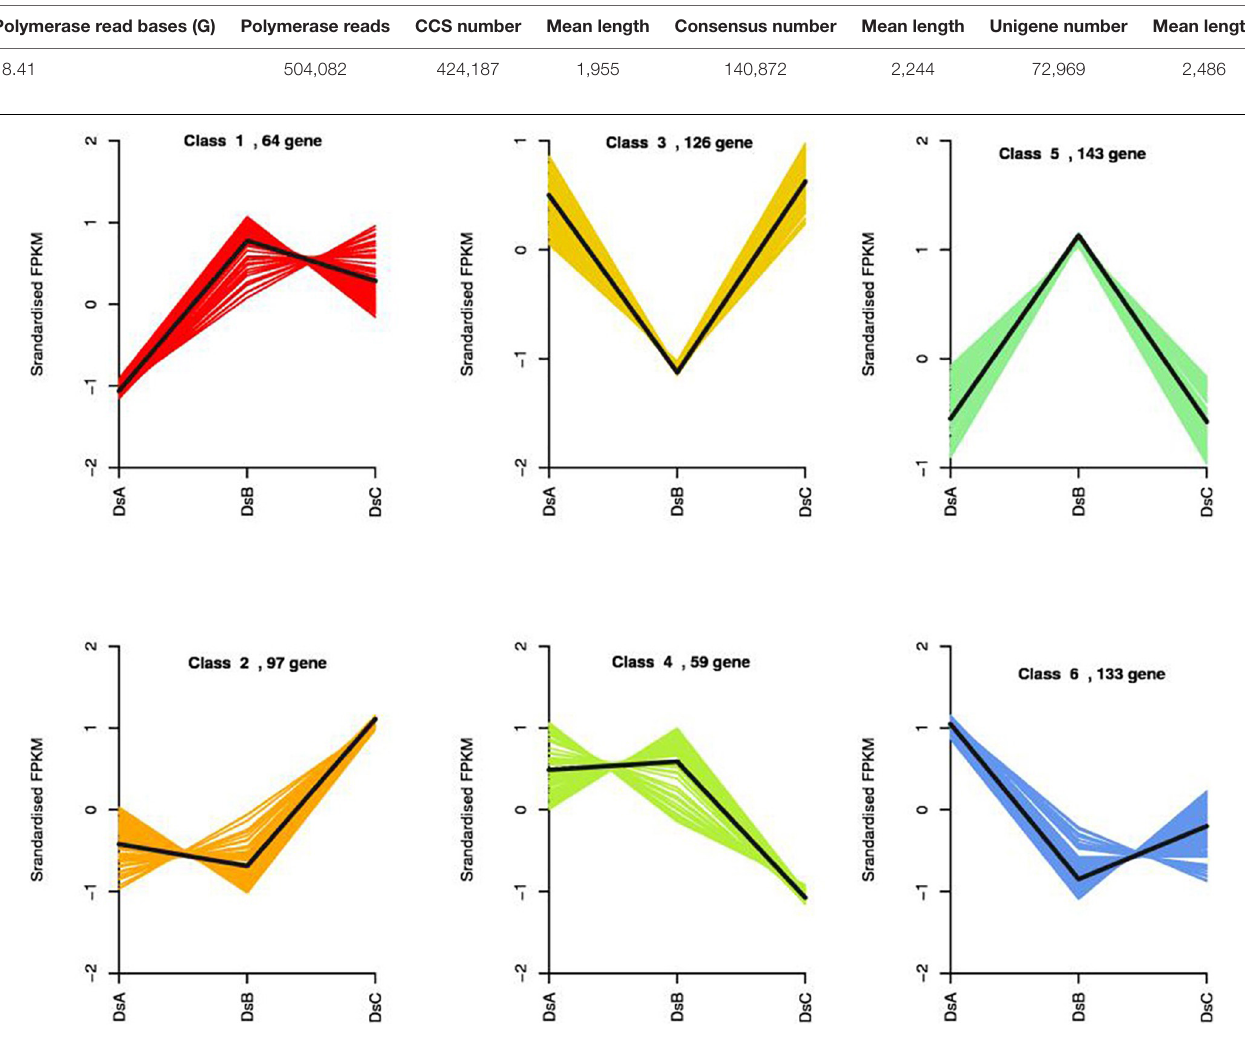
FIGURE 4 | Results of the k-means clustering of 622 DEGs identified by PacBio Iso-Seq based on their expression